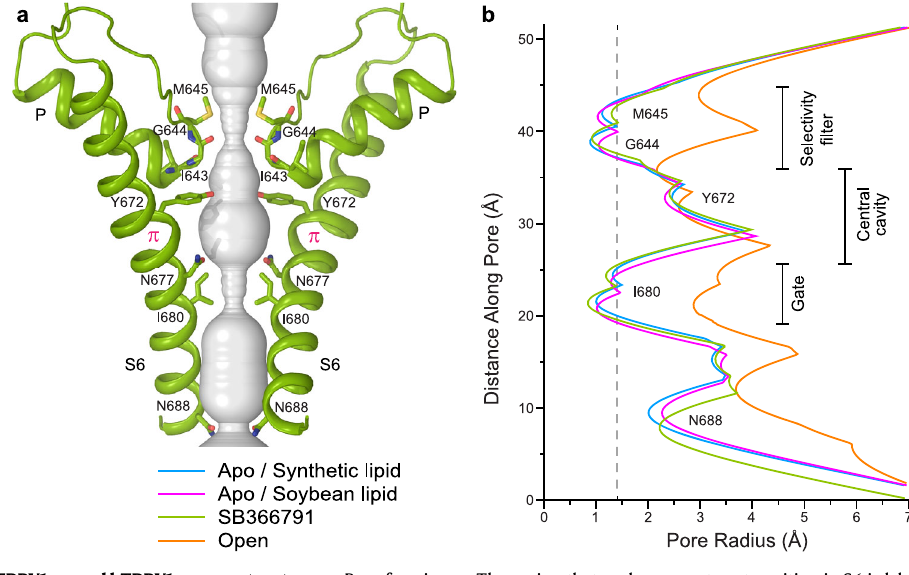
The region that undergoes α -to- π transition in S6 is labeled ( π ). b Pore radius for hTRPV1 Apo insynthetic(blue)andsoybean(pink)lipids,hTRPV1 SB-366791 (green)and rTRPV1 Open (orange;PDBID:7RQW)calculatedusingHOLE.Theverticaldashedline denotes the radius of a water molecule,